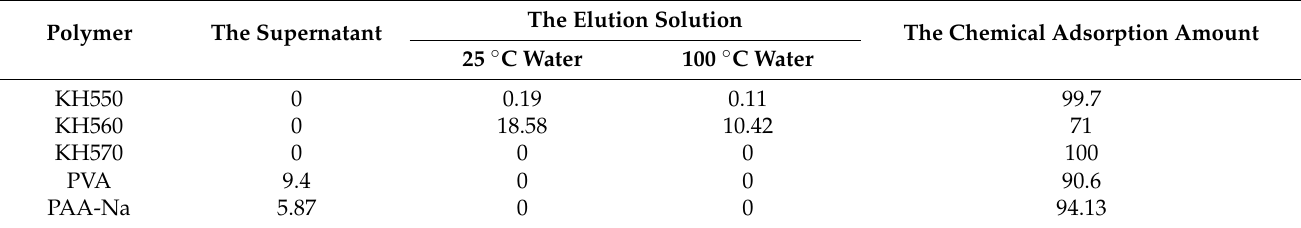
Table 4. The content of different kinds of SCAs and water-soluble polymers in solution by weight (%). The Elution Solution Polymer The Supernatant The Chemical Adsorption